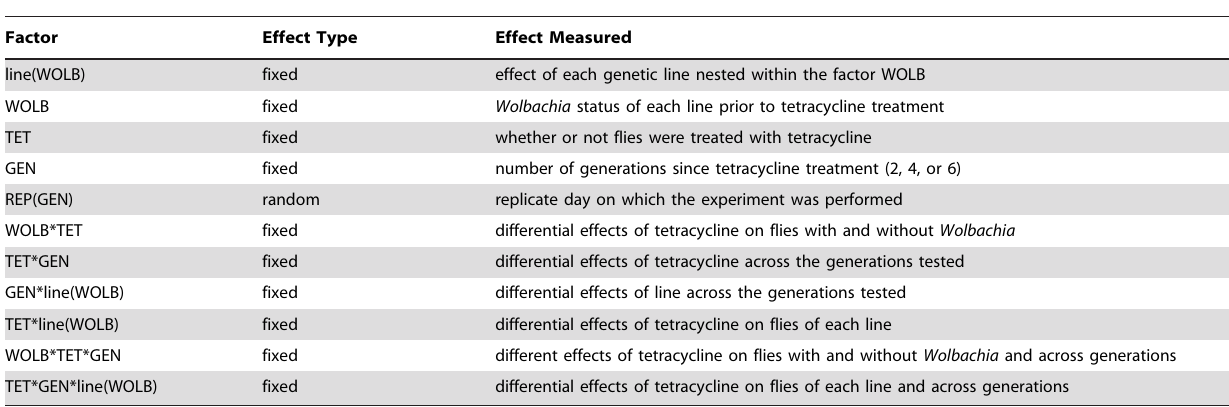
Table 1. Description of Factors Tested in Analyses of